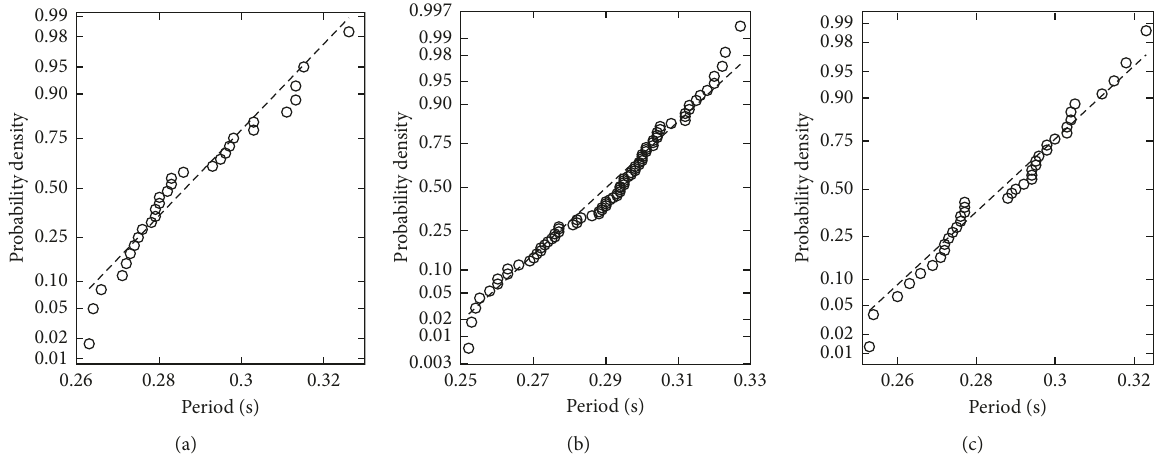
Figure 5: Normal distribution test of swaying periods. (a) 3.0Hz, (b) 3.4Hz, and (c) 3.6 Hz. Table 4: The parameters of normal distribution of swaying frequencies. Crowd swaying frequency